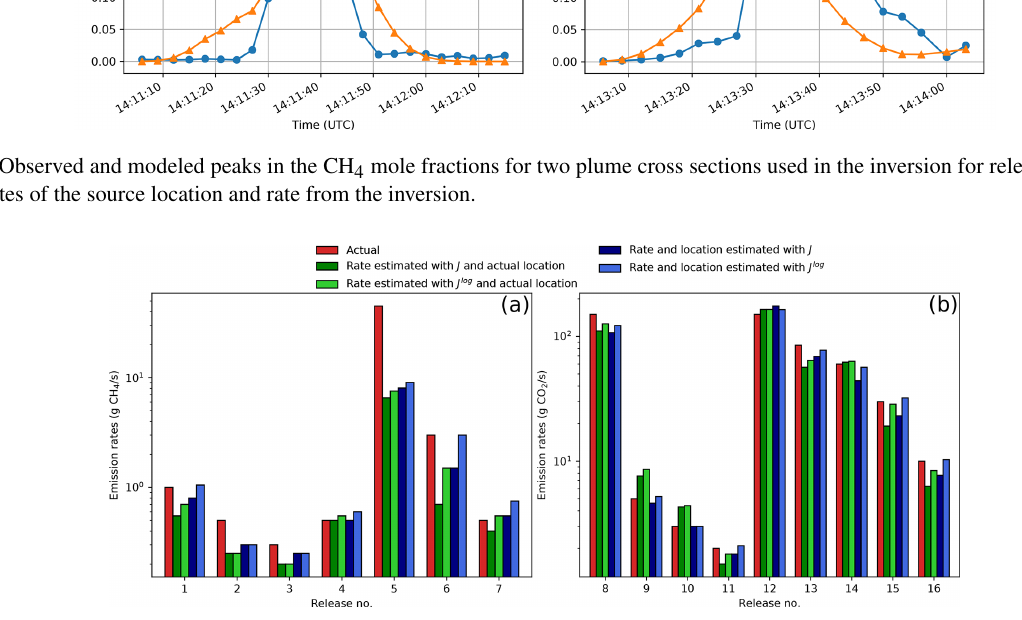
Figure 5. Comparison of the estimated and actual emissions rates of the (a) CH 4 and (b) CO 2